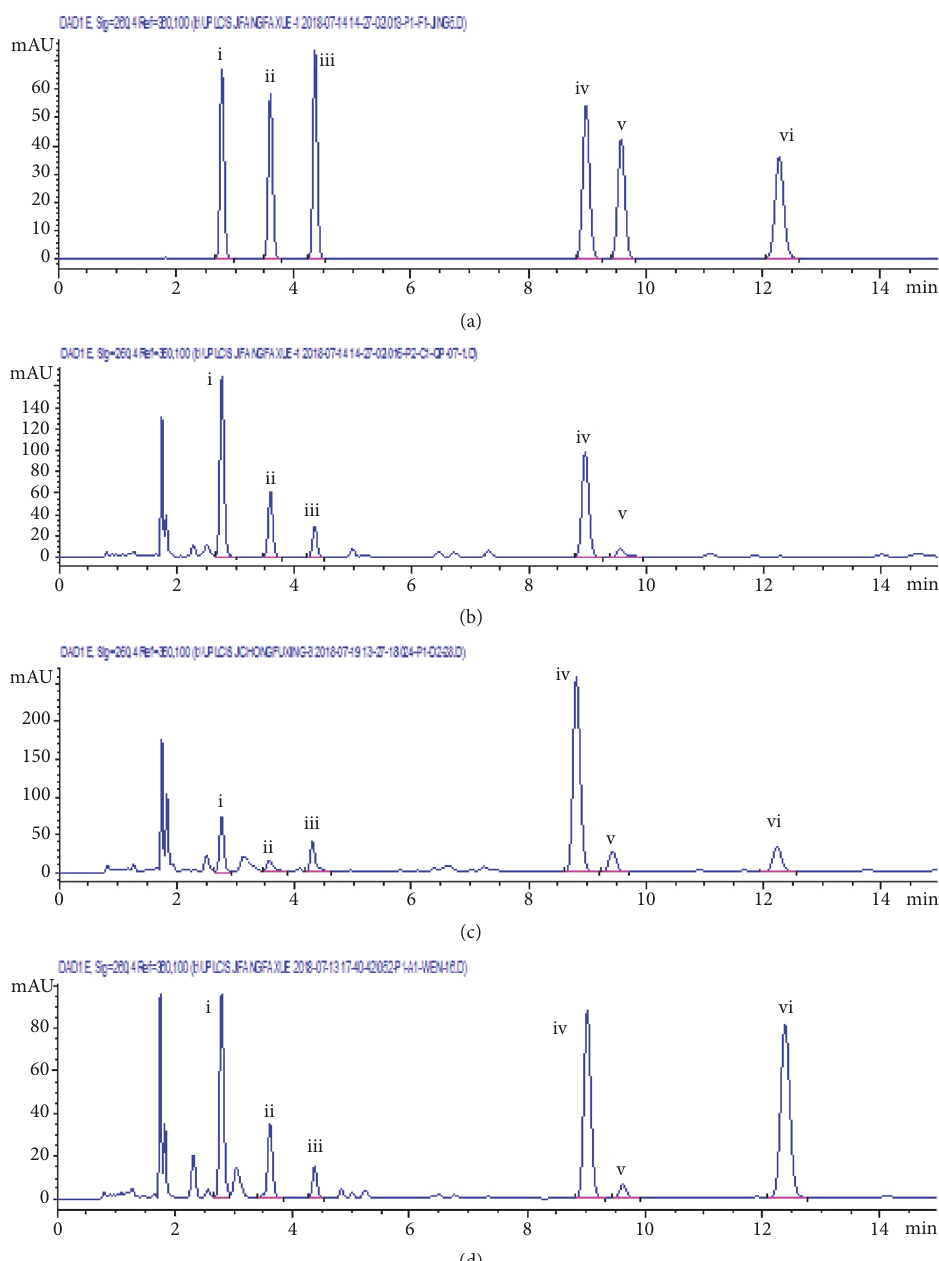
Figure 4: Representative UHPLC chromatograms of mixed standards (a); P. aspergillum (b); M. magna (c); and A. obscuritoporus (d). The peak numbers represent hypoxanthine (i), xanthine (ii), uridine (iii), inosine (iv), guanosine (v), and adenosine (vi) at wavelength 260nm. The method involved an Acquity UPLC HSS T3 column (100mm × 2.1mm, 1.8 𝜇 m) within 20 minutes using a gradient elution with acetonitrile/0.01% formic acid solution as the mobile